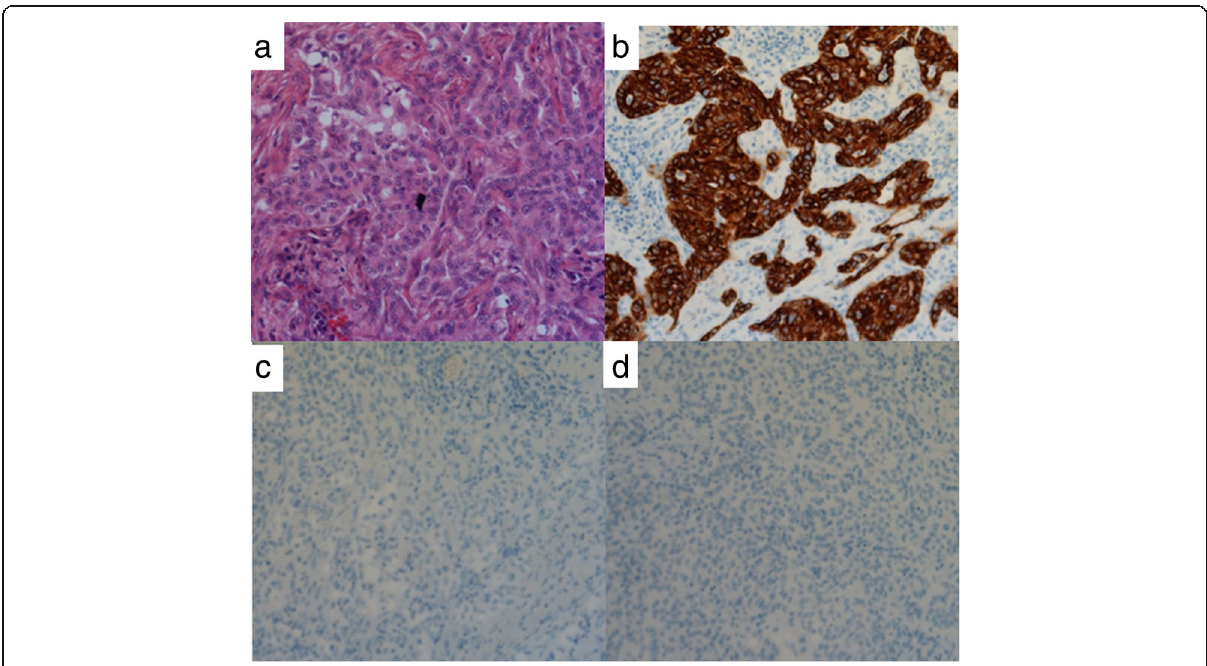
Fig. 6 a Microscopic findings from the lung tumor of S4 show poorly differentiated adenocarcinoma. b CK 7 is positive. c , d CK 20 and TTF-1 are negative (Hematoxylin and eosin staining [× 100] ( a ), and immunohistochemical expression [× 100] of CK 7 ( b ), CK 20 ( c ), and TTF-1 ( d